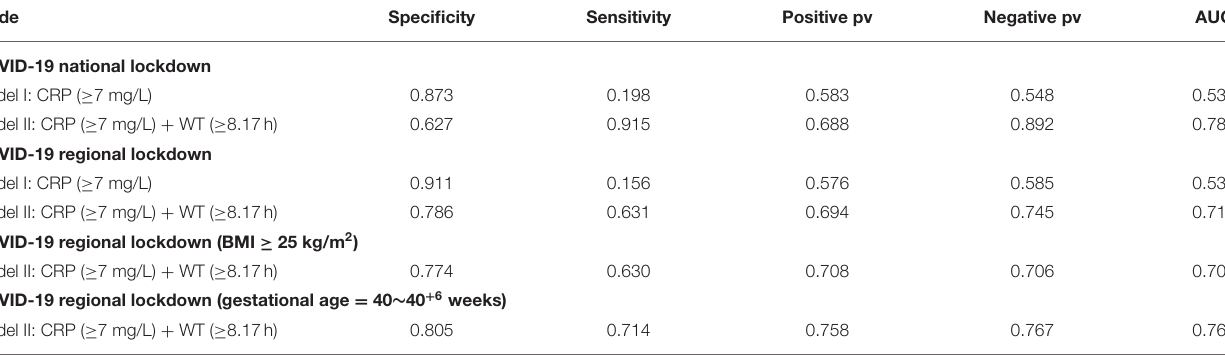
TABLE 5 | AUC, sensitivity, and specificity in both lockdowns and subgroup analysis in regional lockdown with CRP of 7 mg/L and PROM latency of